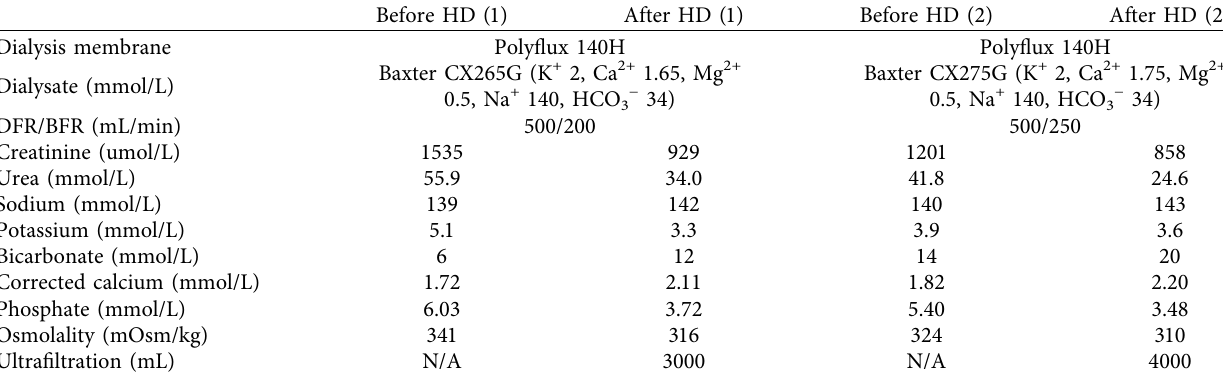
Table 2: Dialysis prescription, before and after haemodialysis biochemistry.